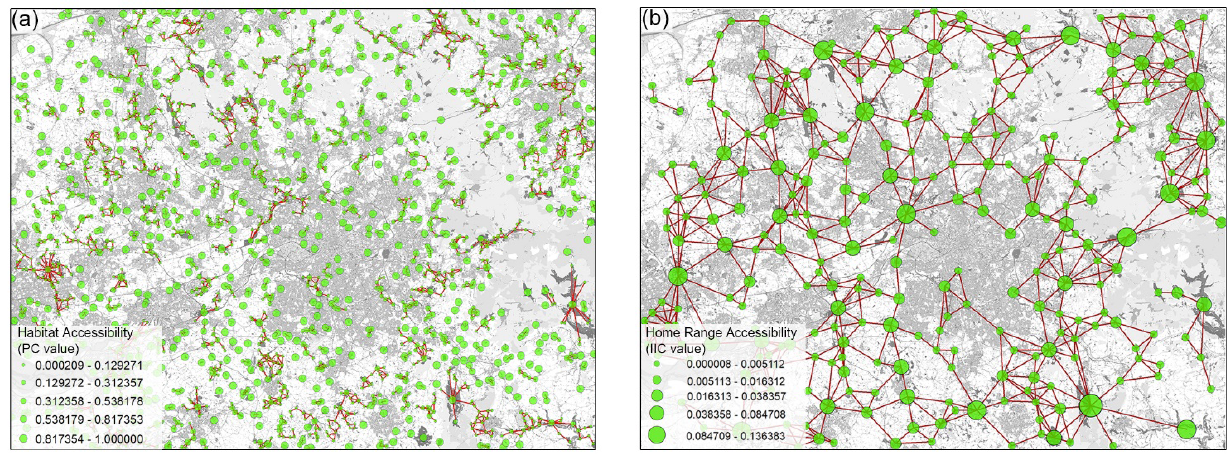
Figure 4. Landscape accessibility for Eurasian jays: (a) habitat accessibility (PC value); (b) home-range accessibility (IIC